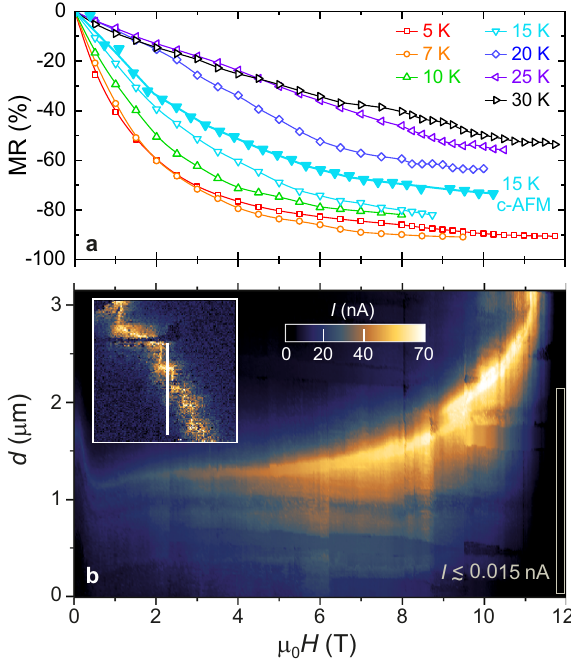
Fig. 4 Giant negative MR of conductive DWs. a MR of a bulk multi-domain crystal at various temperatures, after poling with E p = − 5.5 kV/cm. b Image of c-AFM line-scan recorded while sweeping the magnetic fi eld at 15 K. The color indicates the current for 45 V applied between the tip and the sample. The white vertical line in the inset shows the location of the line-scan in a c- AFM image recorded in zero fi eld. The typical current at the highest fi elds, the region within the gray frame, is ≲ 15 pA. The MR deduced from the fi eld- dependent c-AFM line scans is also displayed in ( a